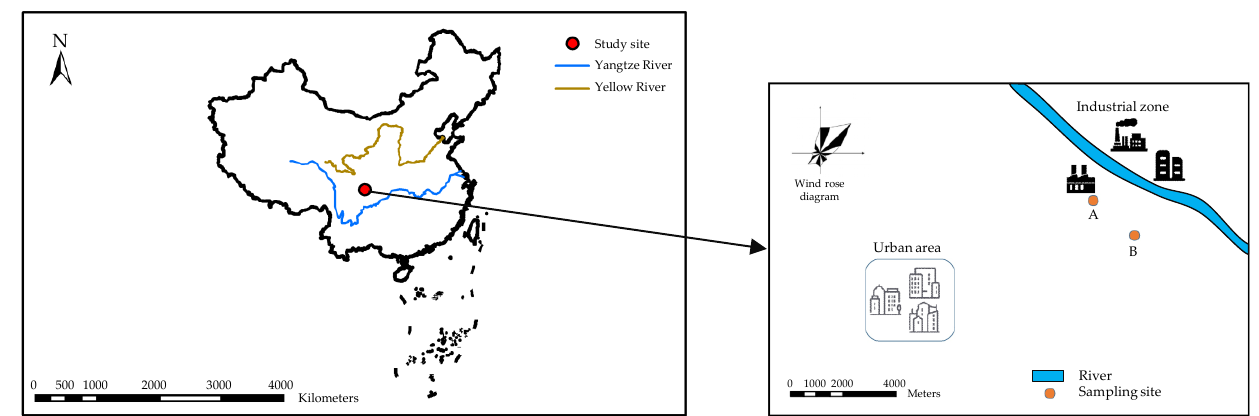
Figure 1. Locations of sampling sites in the downwind area of a phosphorus chemical industrial zone in Shifang, Sichuan, China.